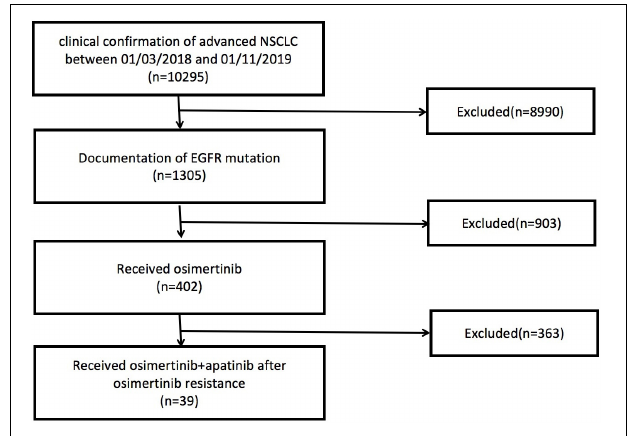
FIGURE 1 | Study cohort selection. EGFR, epidermal growth factor receptor; NSCLC, non-small cell lung